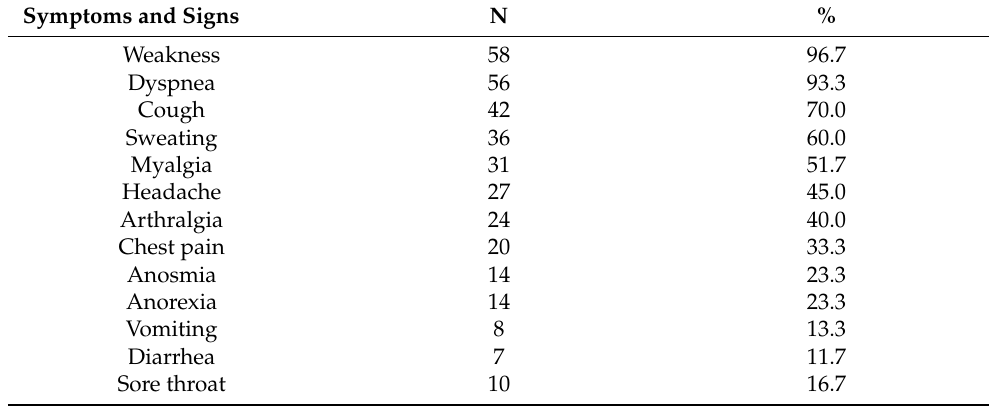
Table 3. Symptoms and signs of